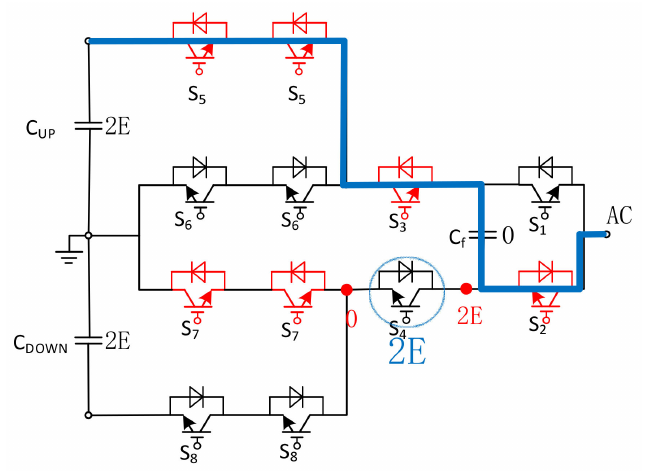
Figure 14. High voltage stress without optimal control.